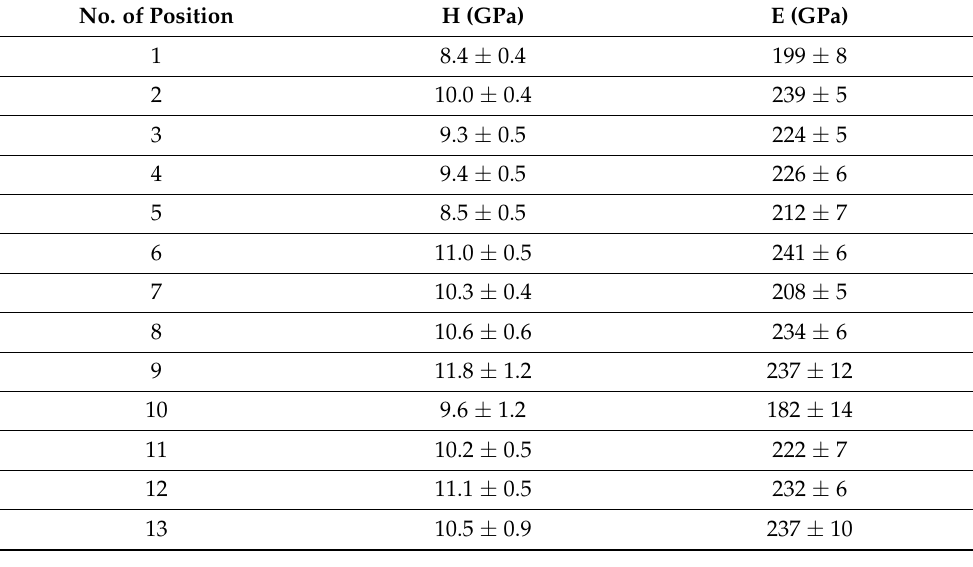
Table 3. The nanohardness (H) and the elastic modulus (E) determined by nanoindentation. The error was calculated as two times the standard deviation of 9 individual measurements.